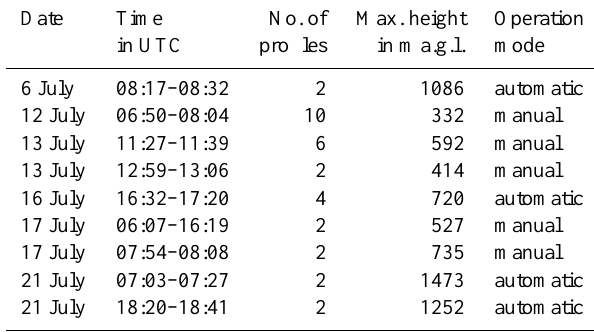
Table 1. List of vertical profiles measured with the M 2 AV during LITFASS-2009.